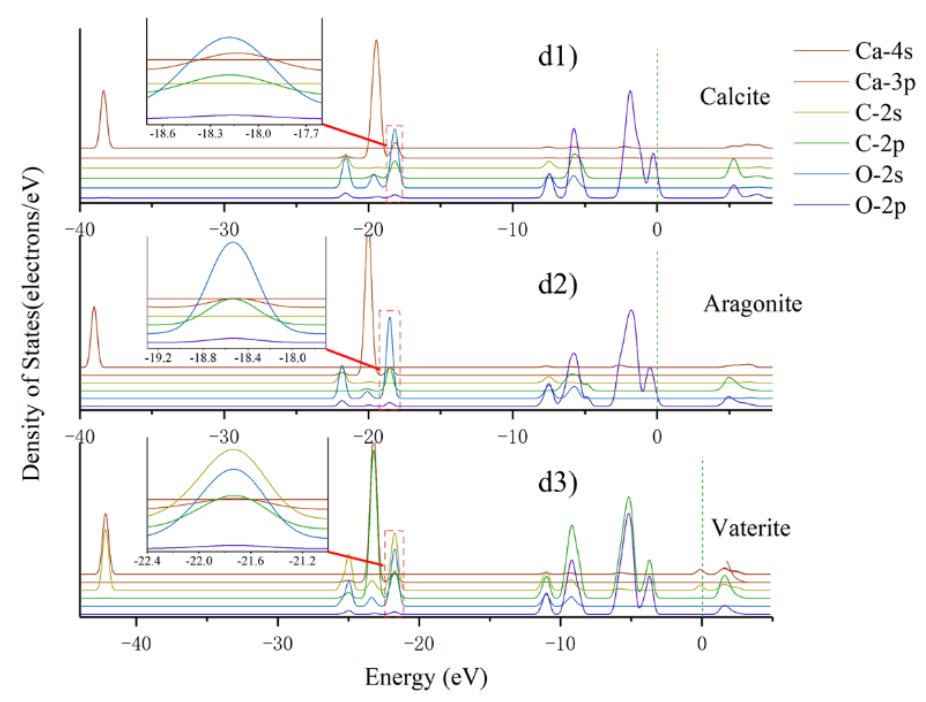
Figure 11. Structure of three crystal calcium carbonate ( a1 – 3 ) calcite; ( b1 – 3 ) aragonite; ( c1 – 2 ) vaterite; ( d1 – 3 ) density of state of calcite, aragonite, and vaterite.